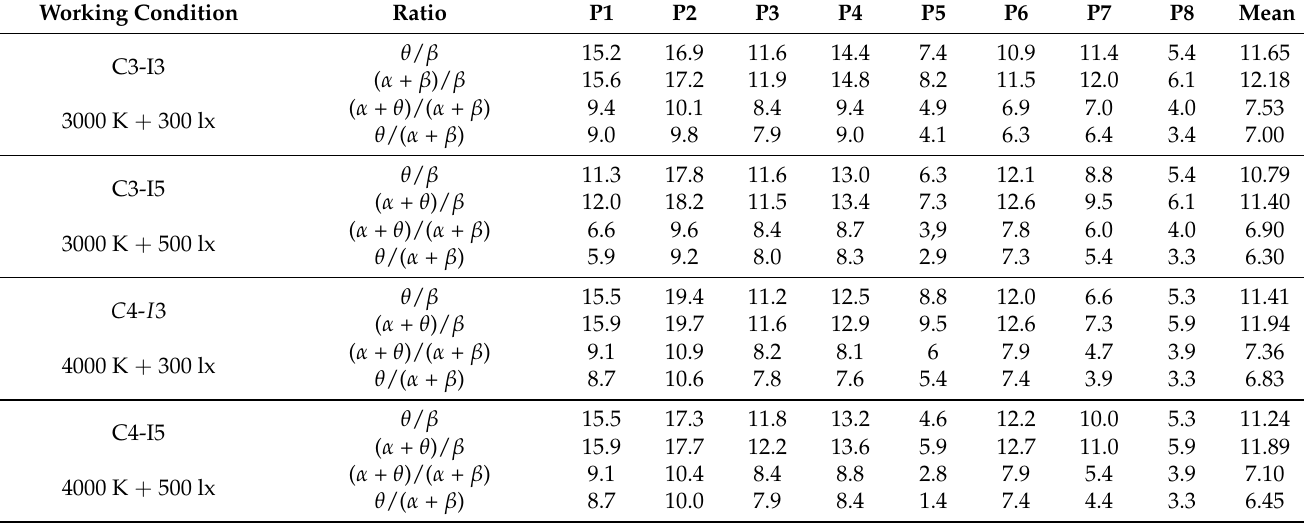
Table 6. EEG rhythm energy